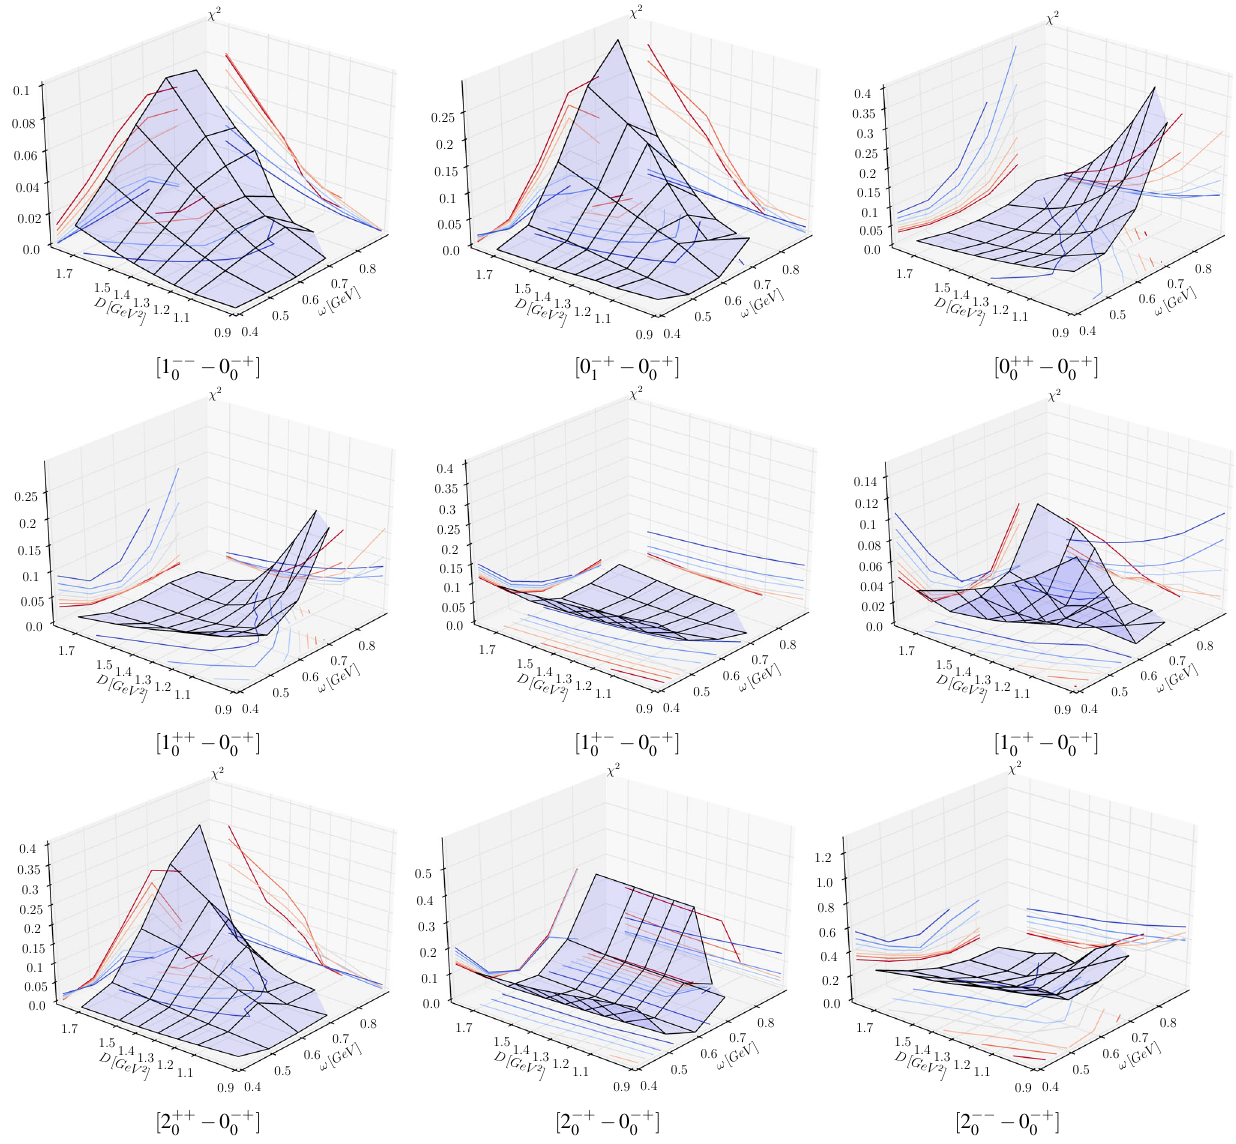
Fig. 14 χ 2 plot from the comparison of our calculated and the experimental other splitting as a function of ω and D